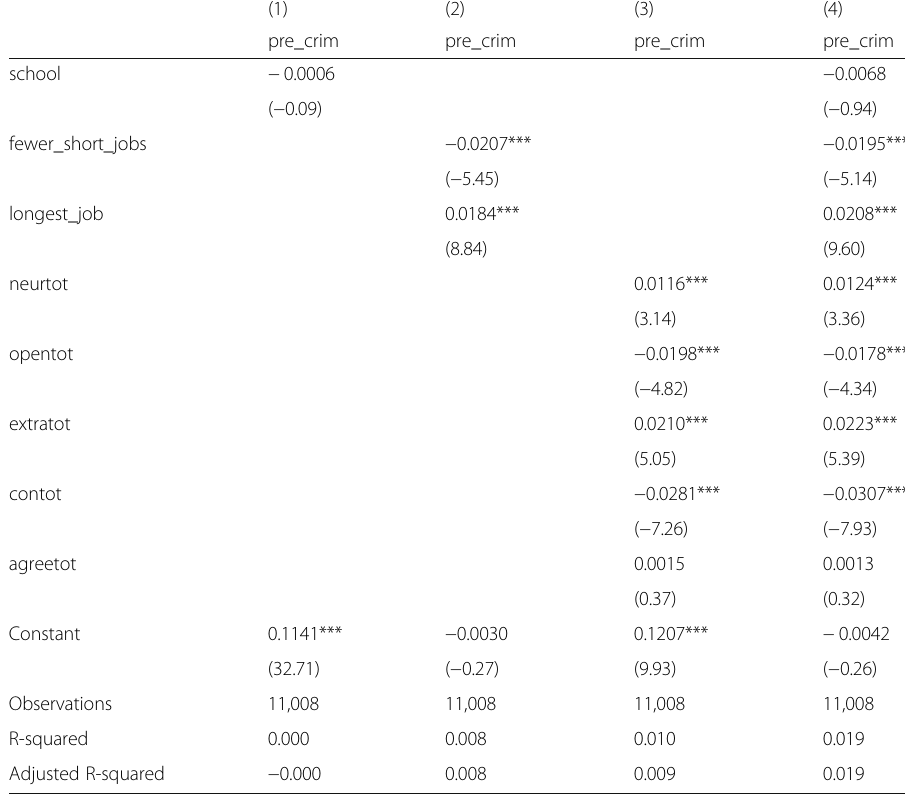
Table 13 Factor-level correlates of criminal background in hired population (all positions)